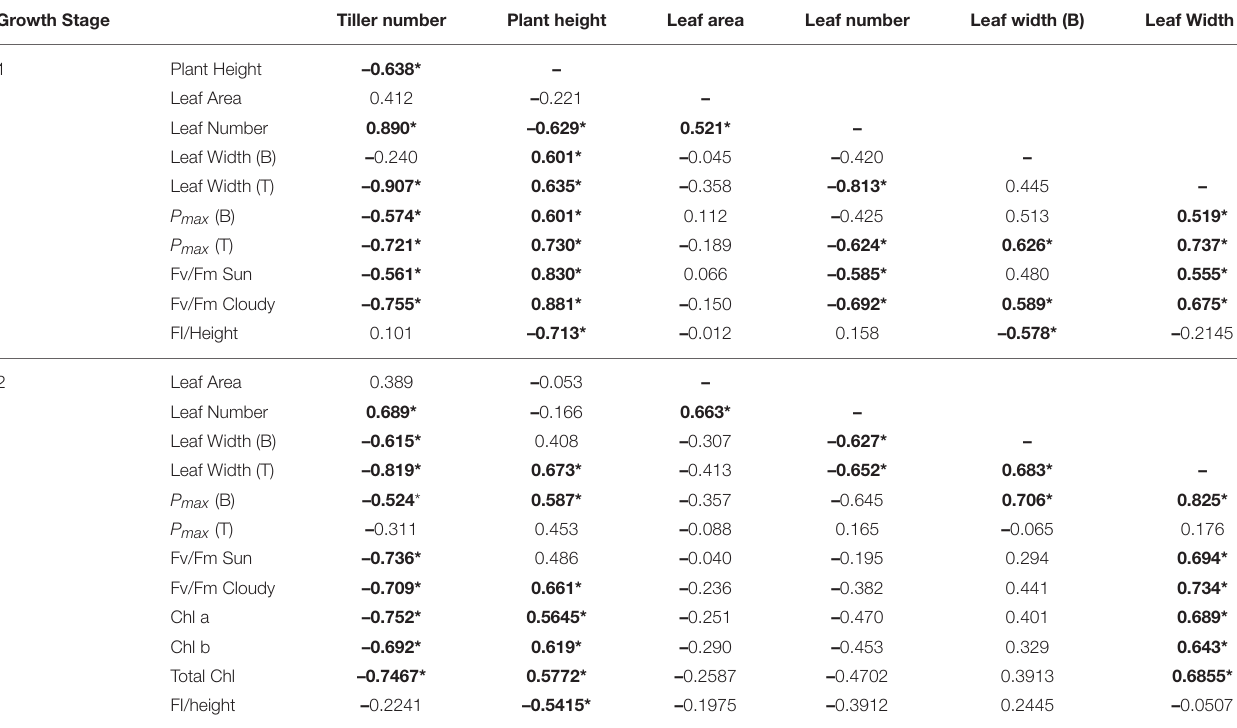
Growth stage 1 corresponds to 45 DAT and 2 at 85 DAT. (T) corresponds to measurements from the top canopy layer and (B) from the bottom canopy layer. FI/Height refers to fractional interception as a function of height throughout the canopy. Significant correlations are given in bold, * indicates P < 0.05. Correlations based on plot means. Dry weight was not significantly correlated to any trait and so is not